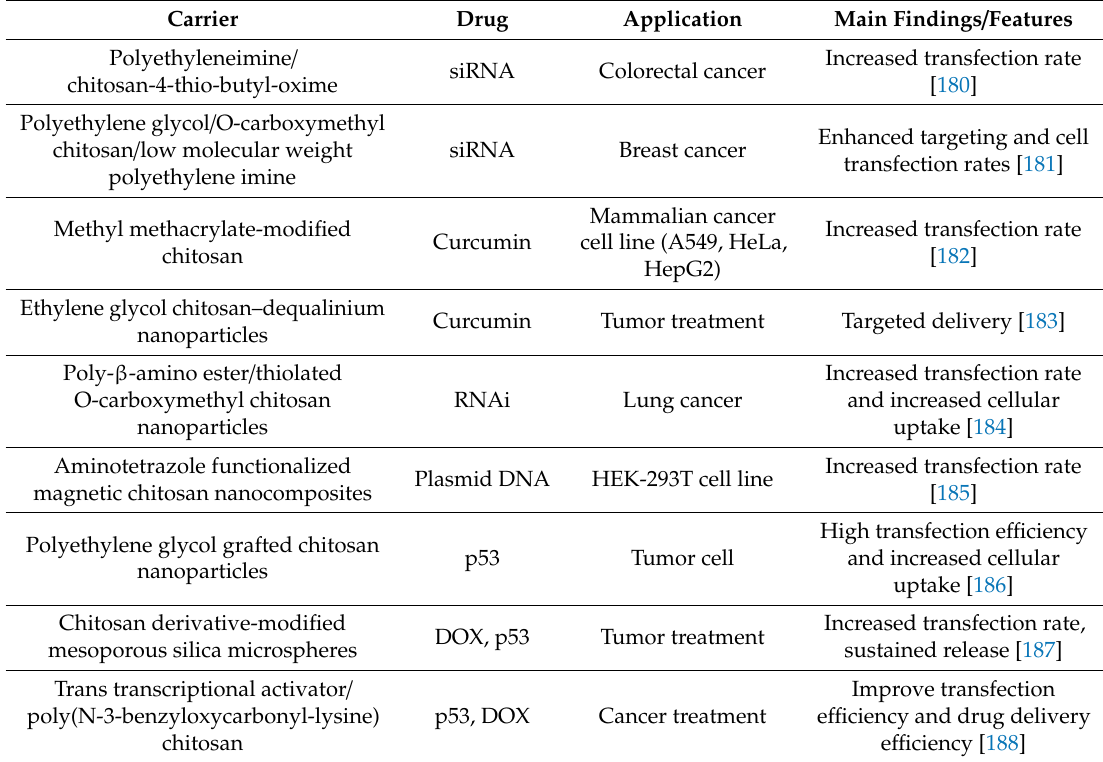
Table 3. Gene carrier-containing chitosan derivative and